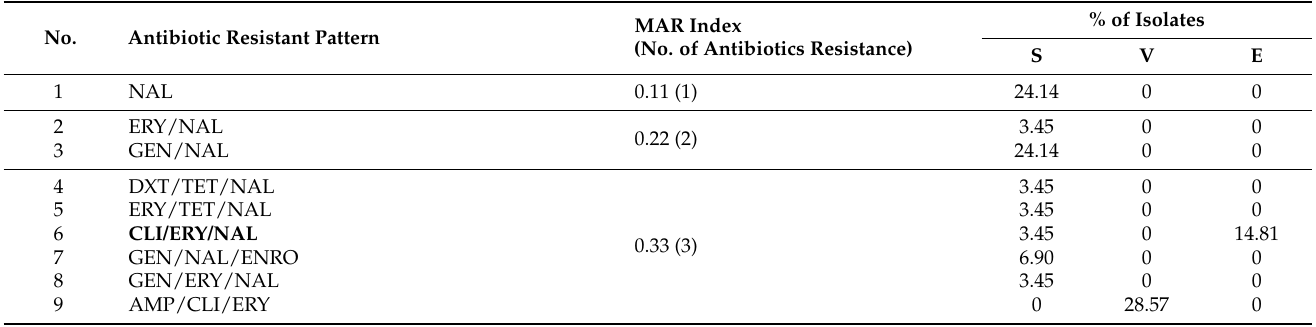
Table 3. Multiple antibiotic resistance index (MAR) and resistance pattern of bacterial